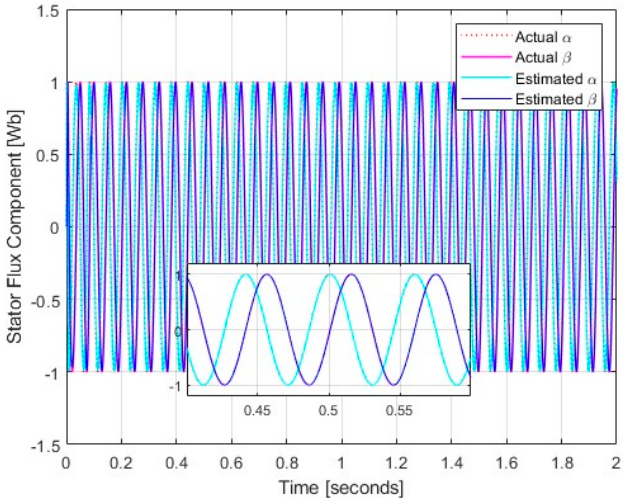
Figure 7. Stator flux components.